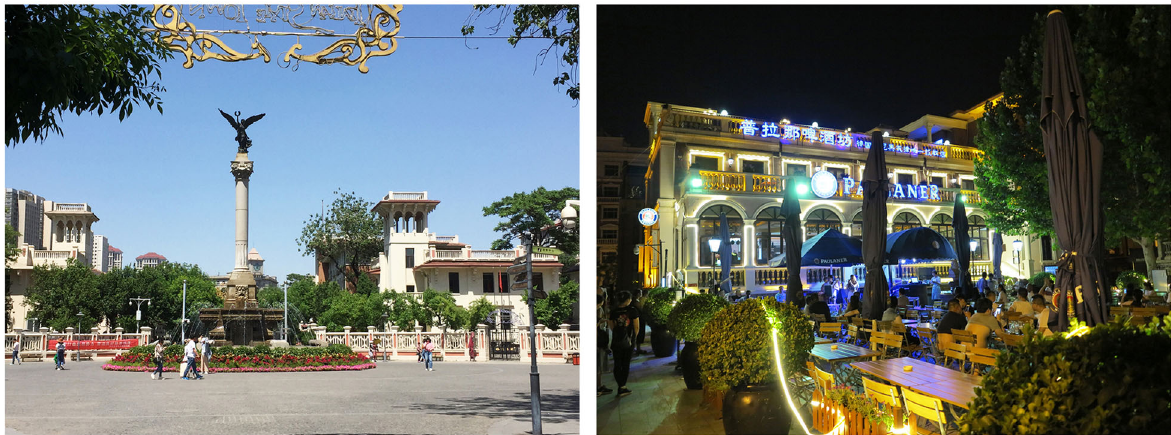
Fig. 12 A villa in Marco Polo Square transformed into a restaurant (Paulaner) in the New I-Style Town in Tianjin (Source: Françoise Ged and Emilie Rousseau,